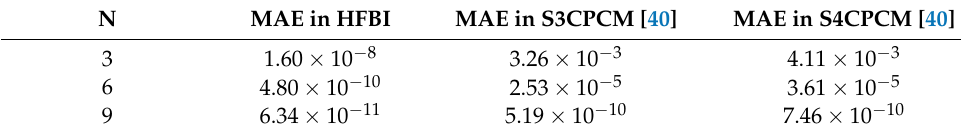
Table 6. Comparison of MAE in HFBI with MAE in S3CPCM and S4CPCM both proposed by [40] for Problem